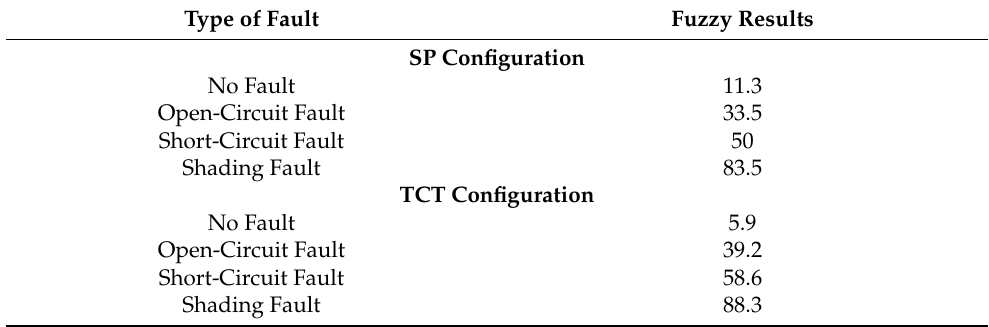
Table 5. Classification of PV